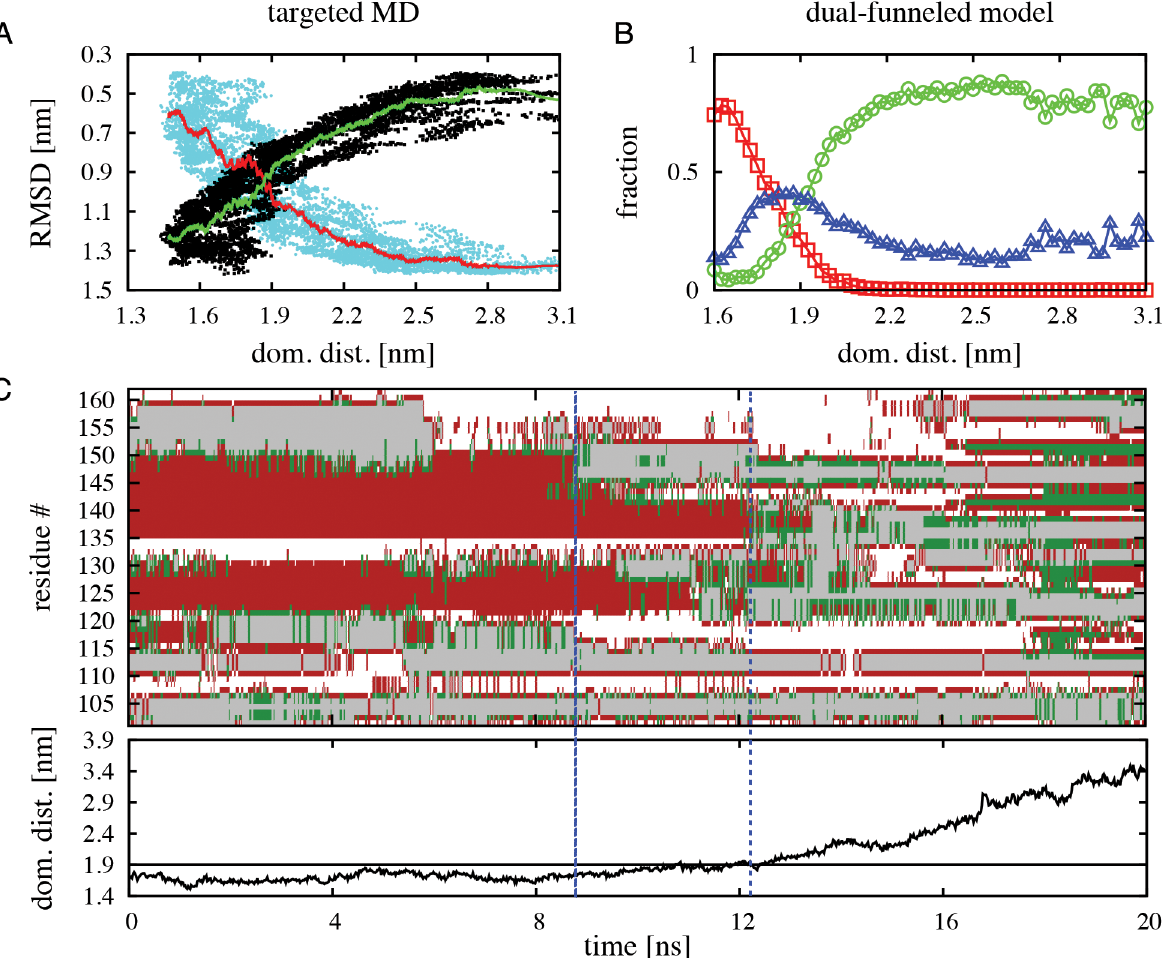
Fig 4. TMD simulations of the α -to- β structural transformation of full RfaH protein in explicit solvent. (A) Change in RMSD of α CTD (cyan dots) and β CTD (black dots) for all TMD simulations as a function of the center of mass distance between the NTD and CTD domains. The red and green lines indicate the average change in RMSD of α CTD and β CTD, respectively. (B) Fraction of CTD in the α (red symbols), intermediate (blue symbols) and β (green symbols) folds as a function of the center of mass distance between the NTD and CTD domains estimated from dual-funneled simulations at ε IF C ¼ 0 : 51 ε . (C) Typical TMD trajectory of the change in secondary structure content per CTD residue as a function of time. The color code corresponds to helices in red, extended structures in green and turns in grey, while white regions represent coils. The dashed blue lines indicate when signi fi cant loss of helical content in the C-terminus of helix α 2 occurs. The plot on the bottom indicates the change in the center of mass distance between the NTD and CTD during the simulation, where the black line at 1.9 nm indicates when the dissociation process